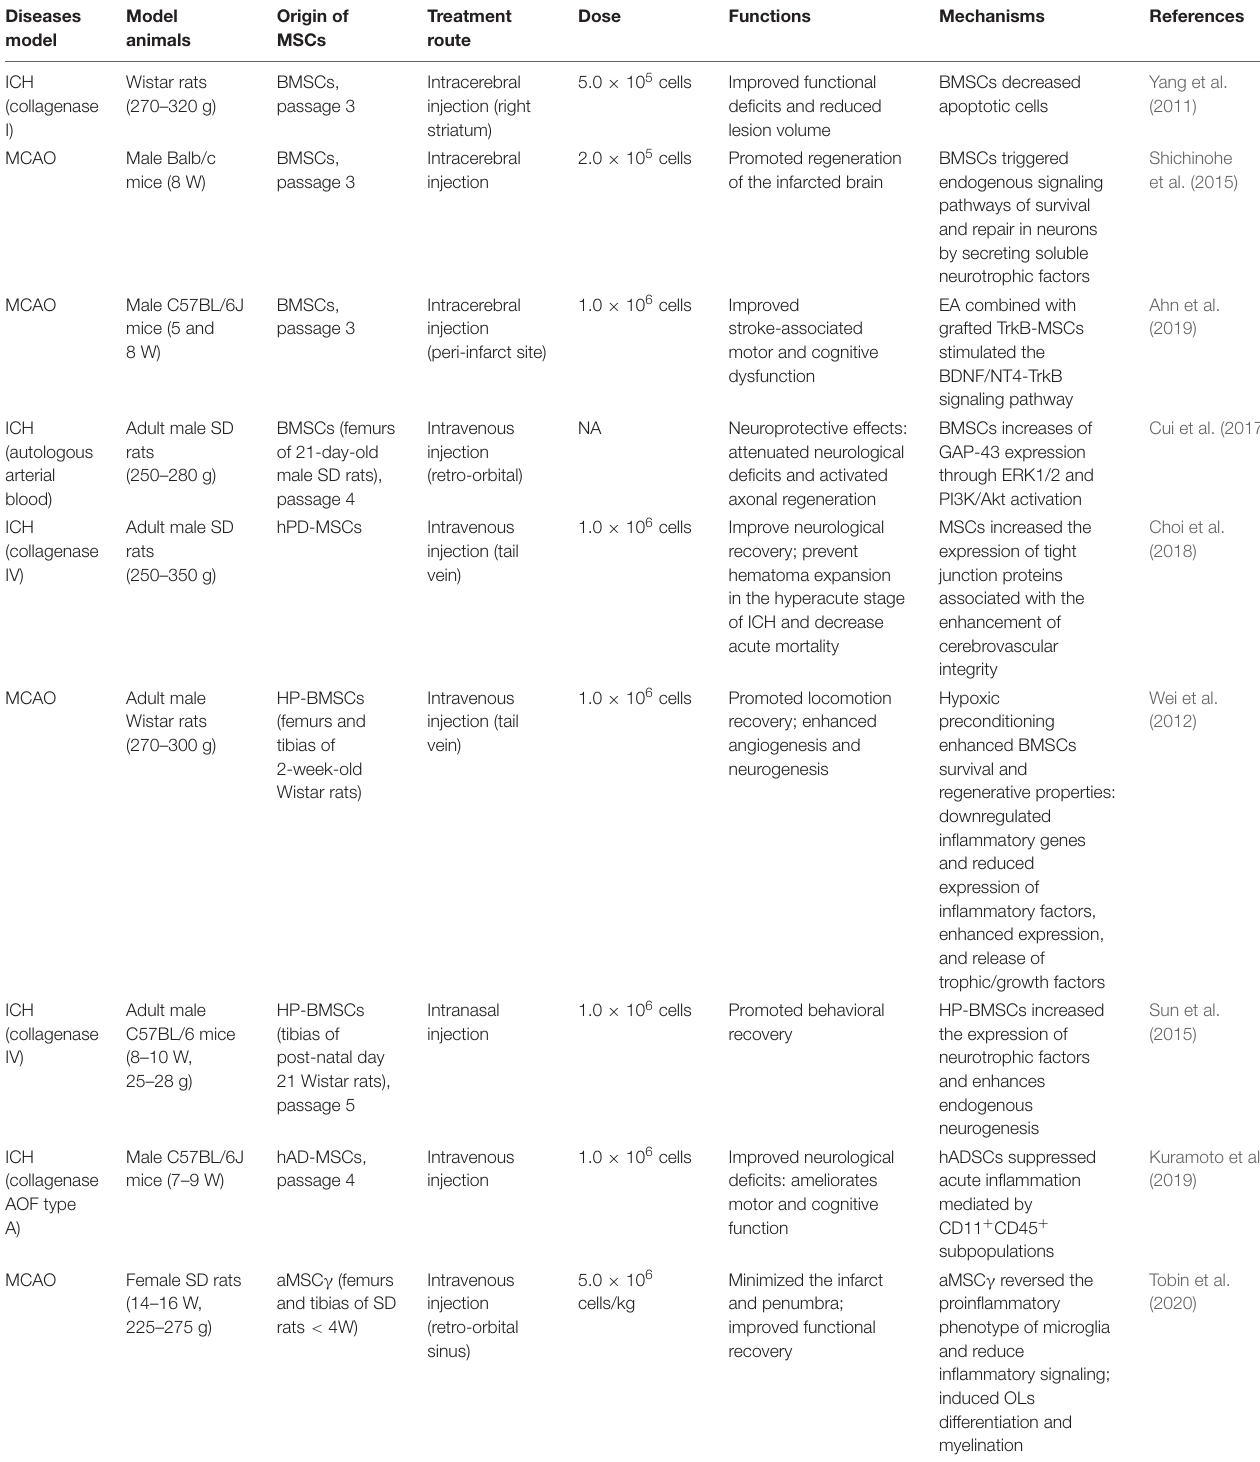
TABLE 1 | An overview of the administration of MSCs involved in animal